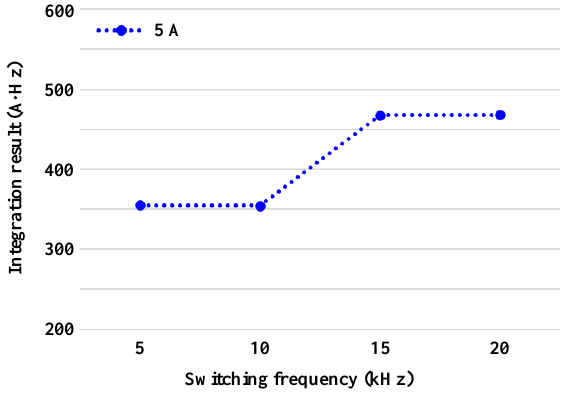
Figure 11. Integral results from 5 kHz to 40 kHz for Figure 10.